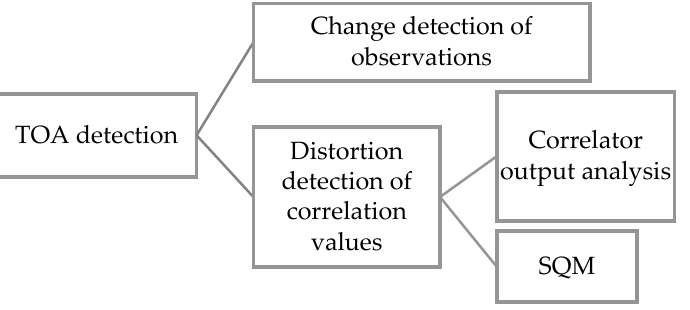
Figure 1. Classification of TOA detection of satellite signals.